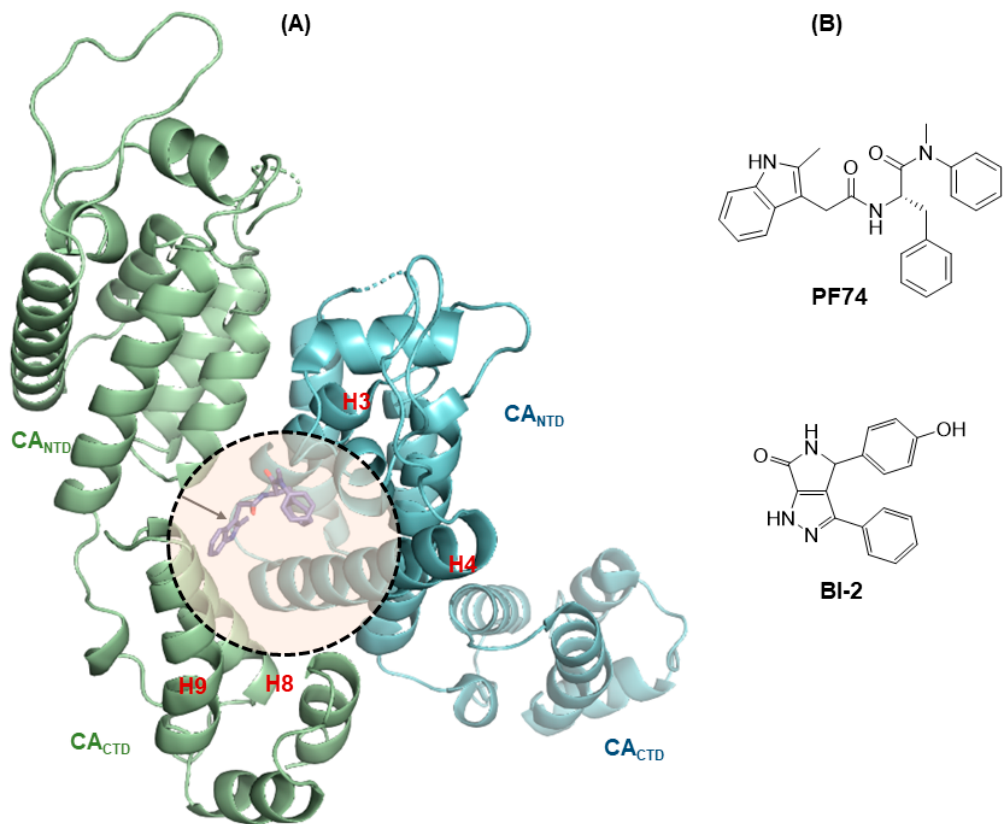
Figure 1. Structure of HIV-1 capsid protein (CA) and a key CA ligand binding pocket. ( A ) The structure of CA dimer (Protein Data Bank code: 4XFZ [25]). The pocket formed around H3 and H4 of the CA NTD (cyan), and H8 and H9 of the adjacent CA CTD (green) accommodates the binding of multiple ligands, including host factors Nup153 and CPSF6, and small molecules PF74 and BI-2 . Shown in the pocket is PF74 (pointed to with an arrow); ( B ) chemical structures of PF74 and BI-2 .